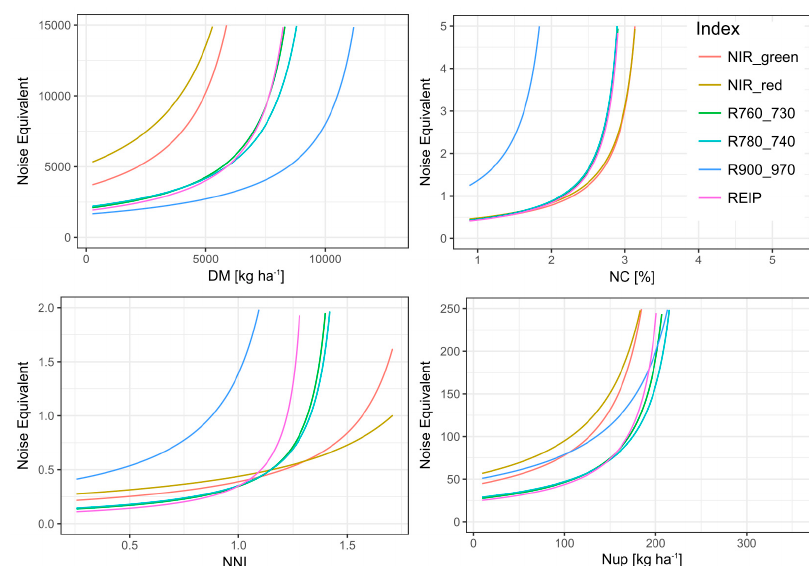
Figure 2. Curves fitted between reference traits and vegetation indices across all measurement dates (year/month/day) for calculating the noise equivalent (Figure 3) for the four reference traits. For each trait, the relationship (***: p < 0.001) of the R 2 -based best index is shown. Fitted values at negative slopes (blue line) were replaced by constant plateau-shaped values (orange line). RMSE values refer to the index values.